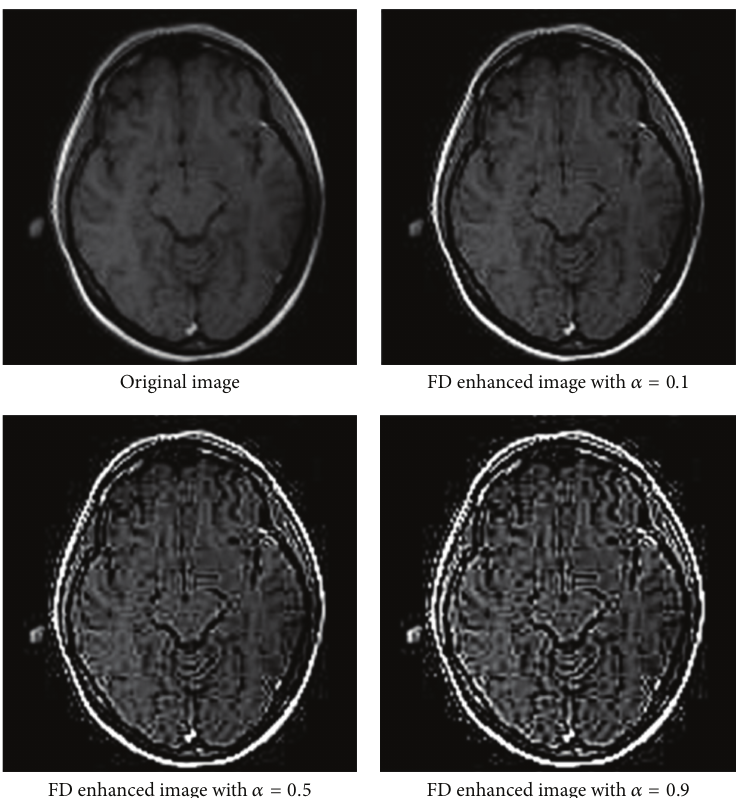
Figure 5: Summary of the results of the proposed enhancement for 𝛼 = 0.1 , 0.5, and 0.9 in the Riemann-Liouville case where 𝜇 = 0